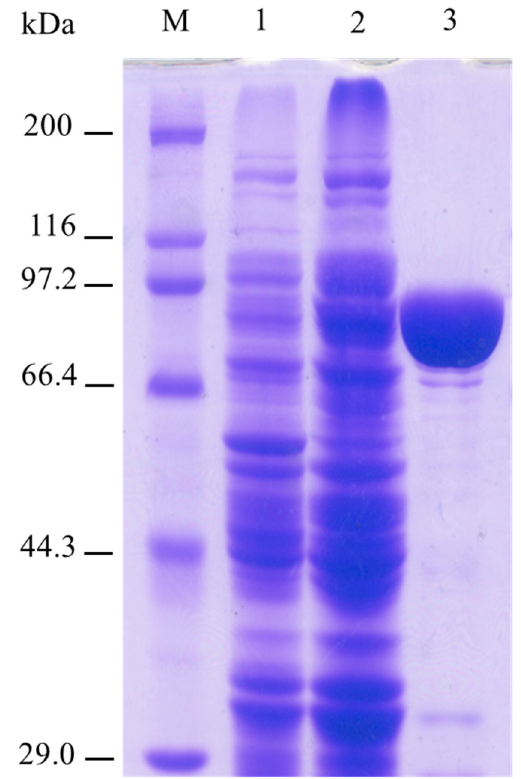
Figure 2. SDS polyacrylamide gel electrophoresis analysis of purified recombinant SpBGL1. M, molecular weight marker (Takara, Protein Molecuar Weight Marker (Broad), D532A); 1—crude protein extraction of JM109 harboring pQE30; 2—crude protein extraction of JM109 harboring pQE-SpBGL1; 3—purified SpBGL1.